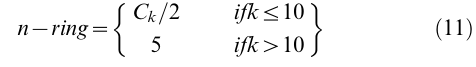
Figure 5. Flow chart of the restoration process. Flow chart of the dual-resolution semi rigid and free-form restoration process.